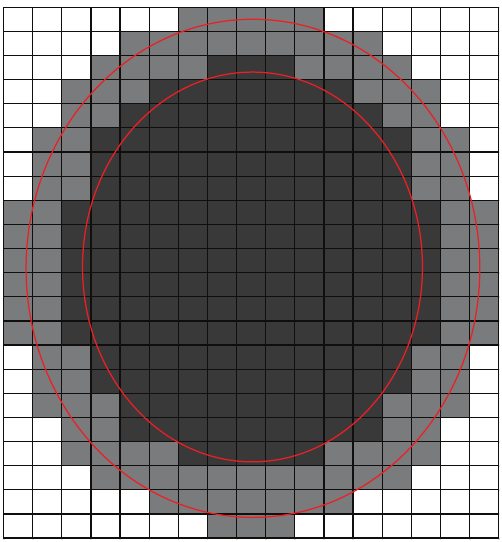
Figure 1: Upper approximation set of an interval set.